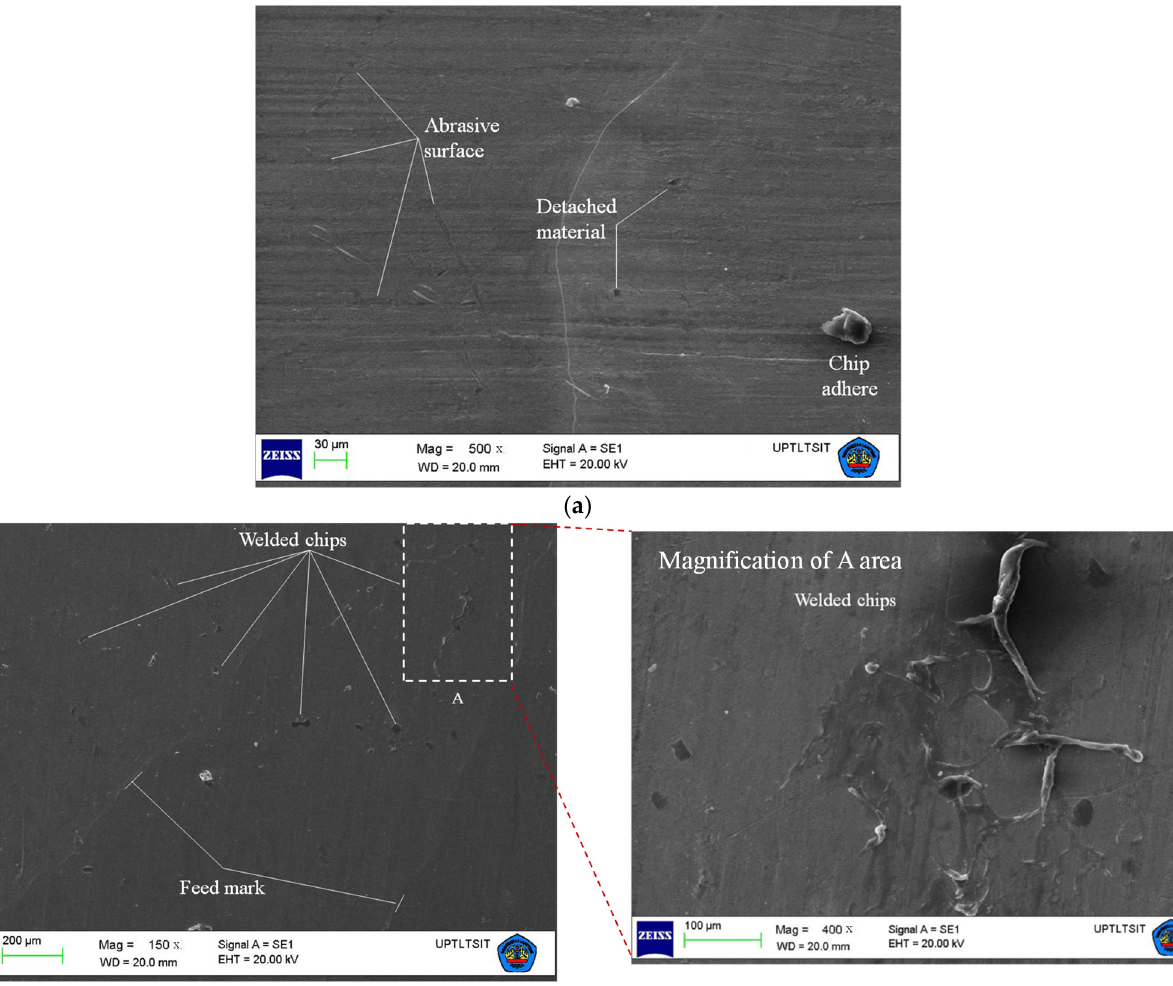
Figure 11. The surface damage of Ti-6Al-4V ELI when machined at cutting speed: ( a ) 60 m/min; ( b ) 210 m/min.